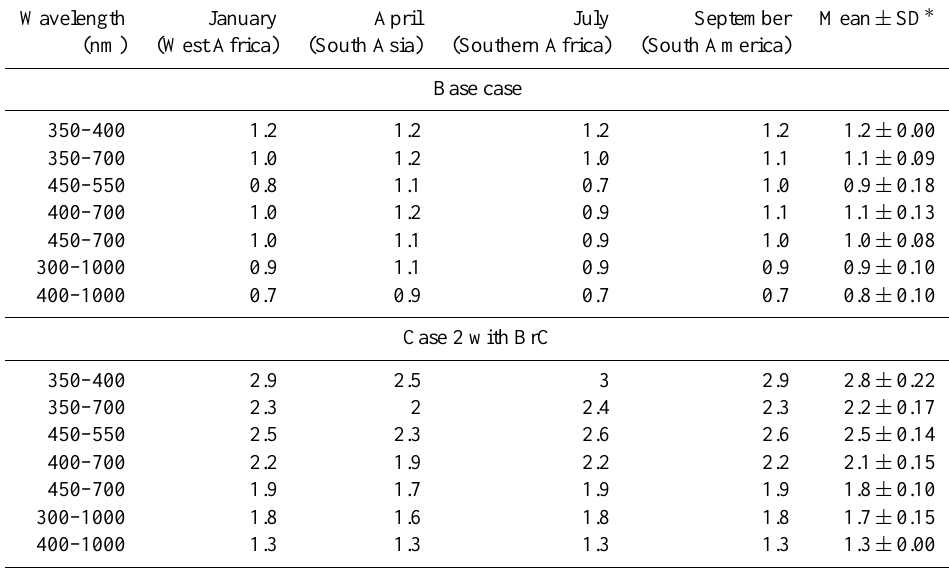
Table 6. The absorption Ångström exponent (AAE) values for major biomass burning regions and seasons obtained from the base case simulation without BrC and the case 2 simulation including absorbing